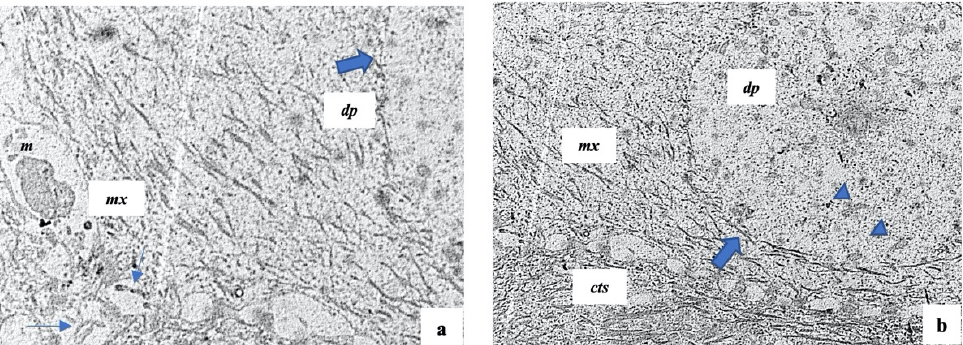
Figure 4. Representative electron microscopical overview of normal scalp hair follicles. cts : connective tissue sheath, mx : hair matrix; dp : follicular papilla; m : melanosomes; thin arrows: keratinocytes in mitotic stage; thick arrows: fine basal lamina of follicular papilla; arrowheads: fibroblasts. ( a ) 6200x; ( b ) 6200x.